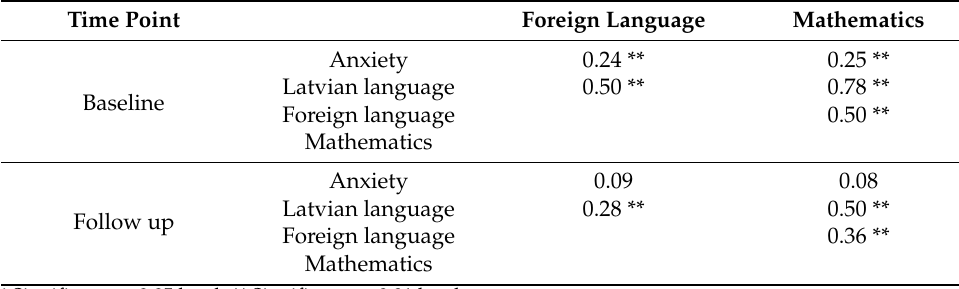
Table A1. Spearman correlations between level of anxiety and student academic performance.